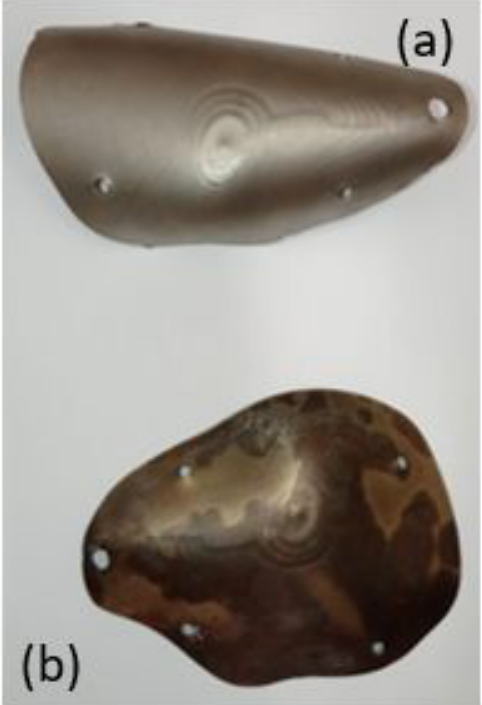
Figure 5. Comparison between samples as received and heat treated at 595 ºC.